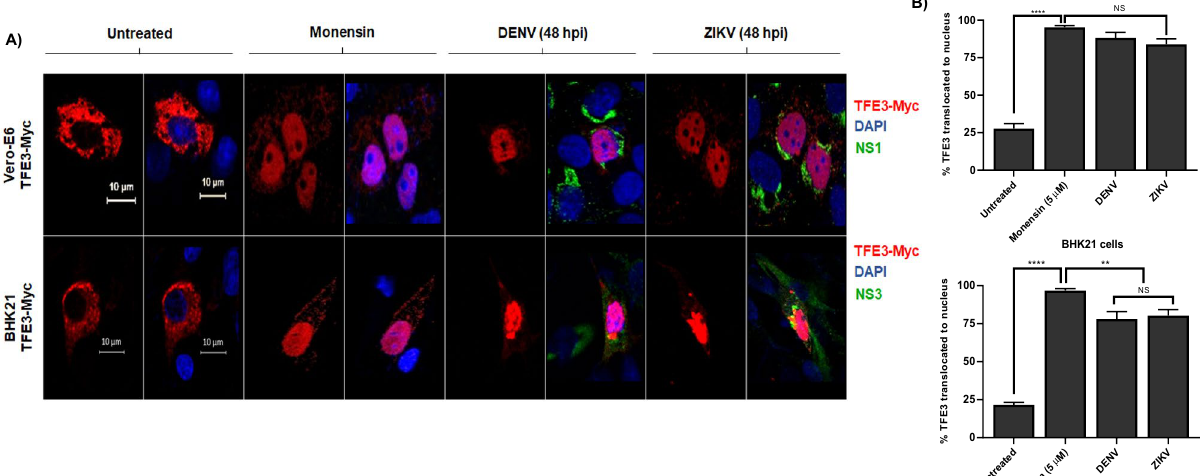
Figure 2. Activation of TFE3 pathway due flavivirus infection in vertebrate cells. ( A ) Cells lines Vero-E6 and BHK-21 were transfected with 1 µg of plasmid DNA of transcriptional factor TFE3 (TEF3-Myc). Twenty-four h after transfection, cells were treated with monensin and fixed 24 h after treatment or infected with DENV and ZIKV and fixed 48 hpi. Cells were probed against flavivirus NS1 (green), and Myc (TFE3, red). Nuclei were counter stained with DAPI (blue). Merged fluorescent images of DAPI, red and green channels are shown. The images were analyzed using a LSM 700 confocal microscope with laser sections: 0.45 μm. Images from one out of least 3 independent experiments are shown. ( B ) Percentage of TFE3 translocated from the cytoplasm to nucleus in both cells lines were measured through images analysis with Zen Blue edition 2.6 software and the results were plotted using GraphPAD Prism version 8.01. *p ≤